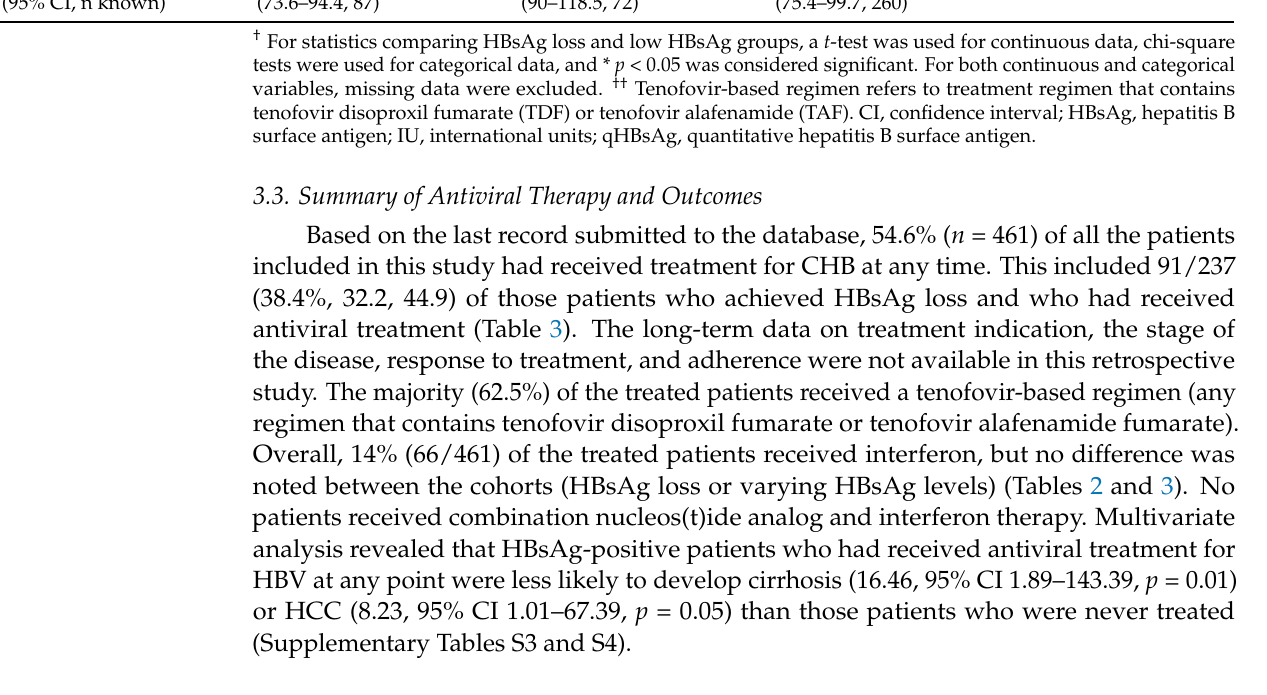
Table 3. Comparison of demographic and clinical data in untreated vs. treated patients included in the